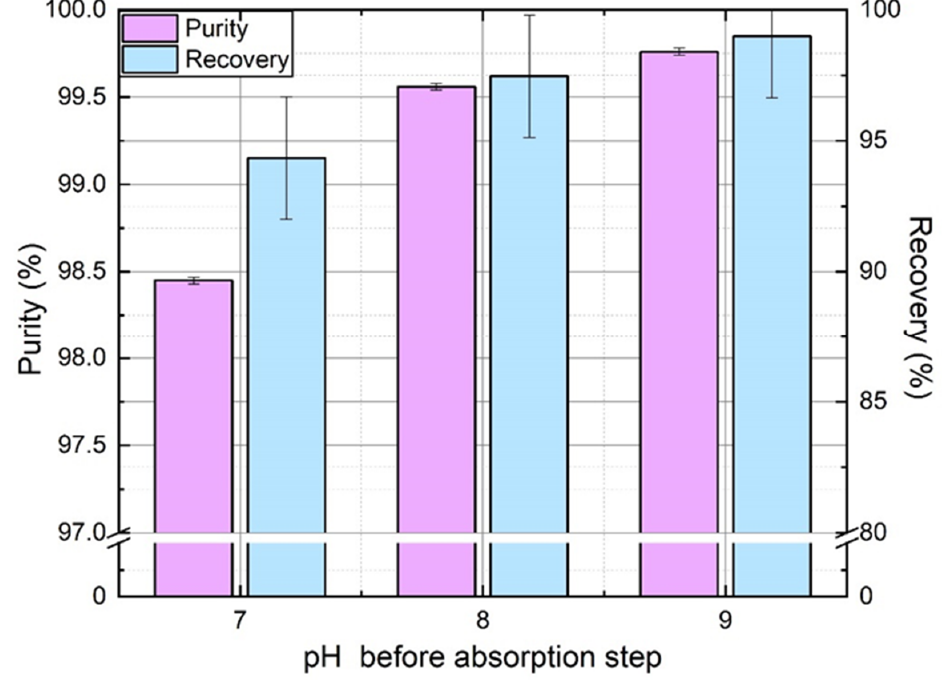
Figure 8. Effect of pH magnitude on N 2 purity and recovery rate, as observed as the pH value before the absorption step for a constant pH = 6 before the desorption step. ( Q l = 150 Lh −1 , P g = 3 bar g , Q g = 100 NL h −1 , y in CO2 = 35%, 1 M KCl solution).